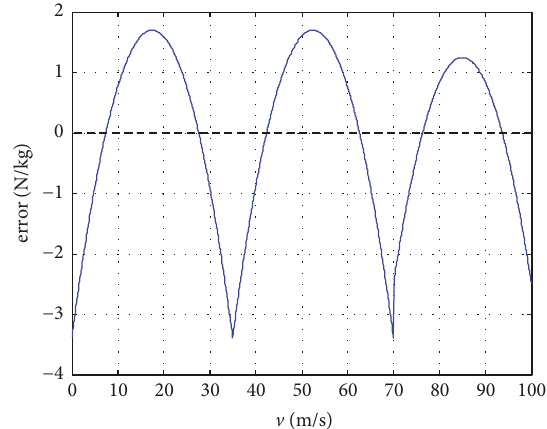
Figure 3: The error between the piecewise linearization of train basic resistance and the original true basic